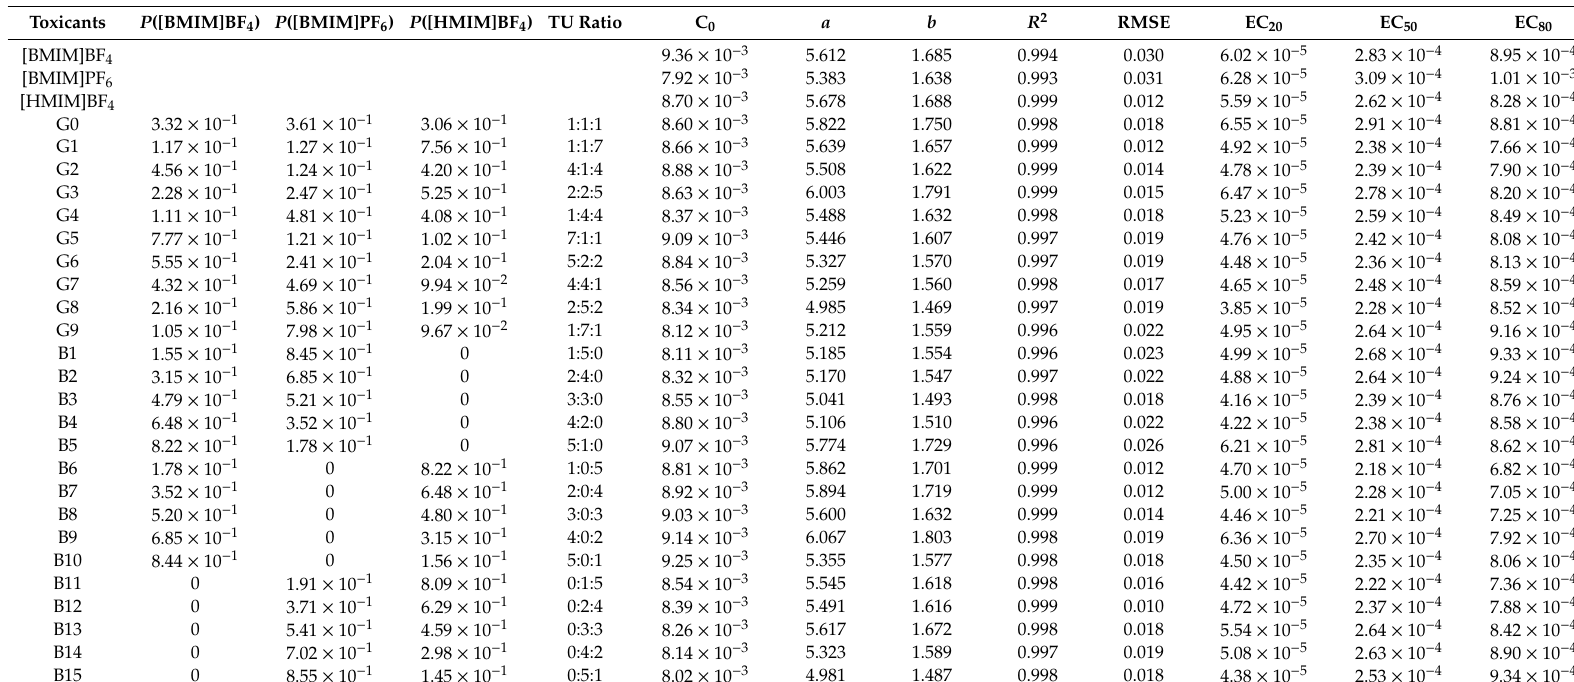
Table 1. Concentration–response model of single ILs and their ternary mixtures (G0–G9) and binary mixtures (B1–B15) inhibiting AChE and related parameters